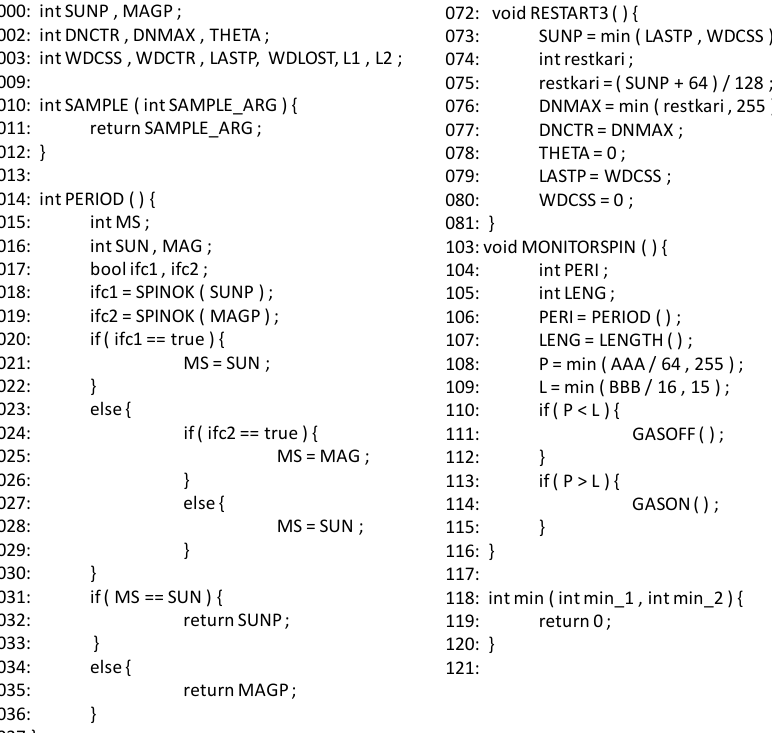
Figure 16. Source codes of spin-stabilized satellite -extracted-.